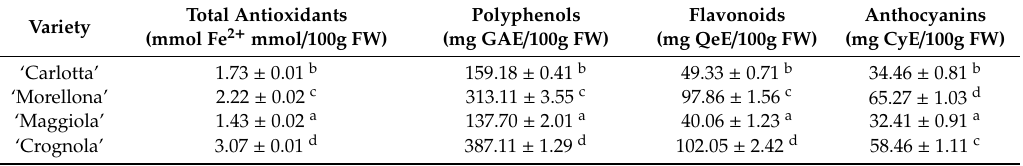
Table 2. The table reports the values ( ± standard deviation, number of independent biological replicates = 3) obtained from the sweet cherry varieties sampled in 2018. The results show the total content of antioxidants expressed as mmol Fe 2 + per 100 g fresh weight (FW), polyphenols as mg of GAE (gallic acid equivalents) per 100 g of FW, flavonoids as mg of QeE (quercetin equivalents) per 100 g of FW and anthocyanins as CyE (cyanidin-3-glucoside equivalents) per 100 g of FW. Di ff erent letters indicate statistically significant di ff erences ( p < 0.05) among groups at the one-way ANOVA with Tukey’s post-hoc test.